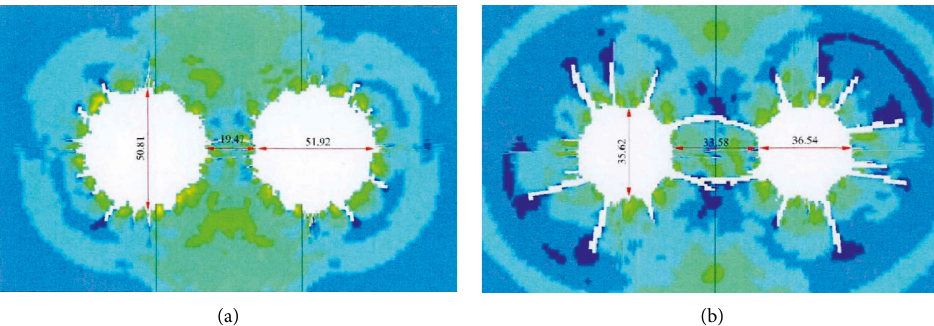
Figure 22: The damage range of surrounding rock when the blasthole spacing is 70cm in (a) conventional blasting technology and (b) ECHBT [68].